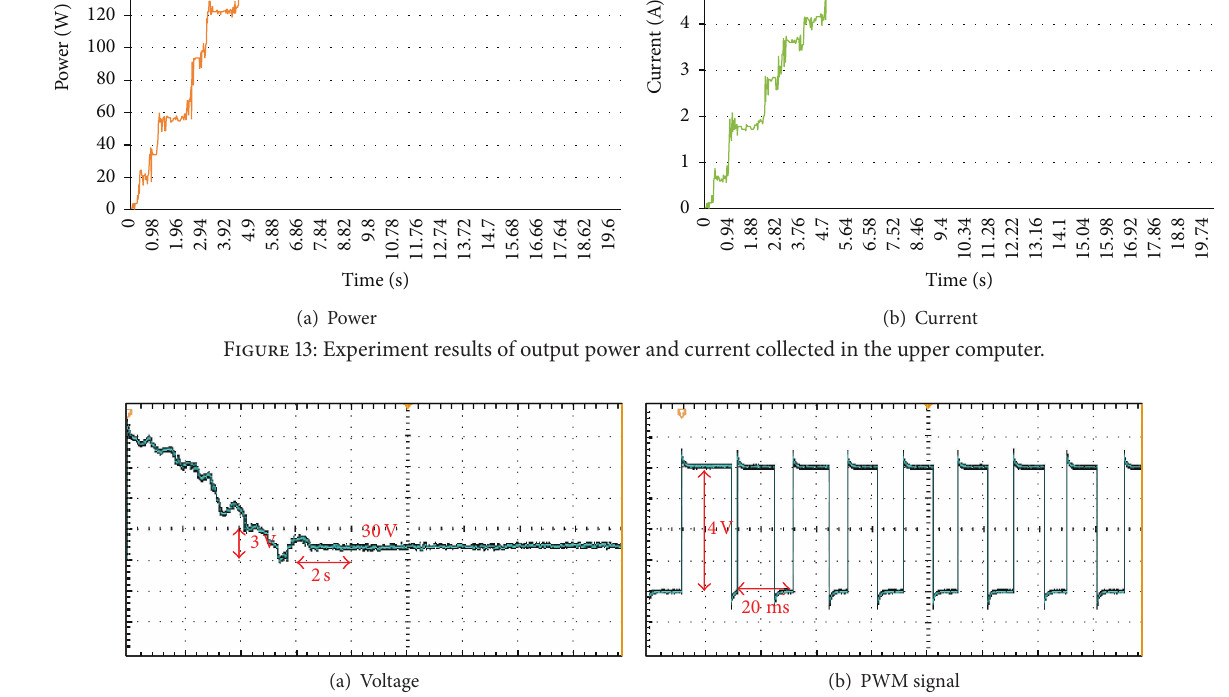
Figure 14: Experiment results of output voltage and PWM signal measured in the oscilloscope.